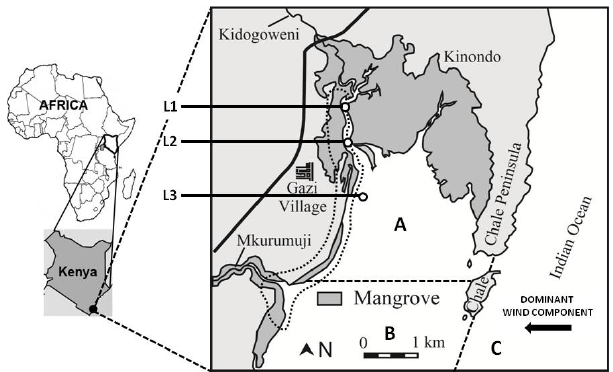
Fig. 2. Schematic depiction of our study area (Gazi Bay), with an indication of the three locations at which propagules were dropped in our field experiment (L1 to L3). The dotted contour represents the area where propagules were sought 12h after having been released. The zones where local fishermen recovered propagules whilst fish- ing are indicated with A, B and C, separated by bold dotted